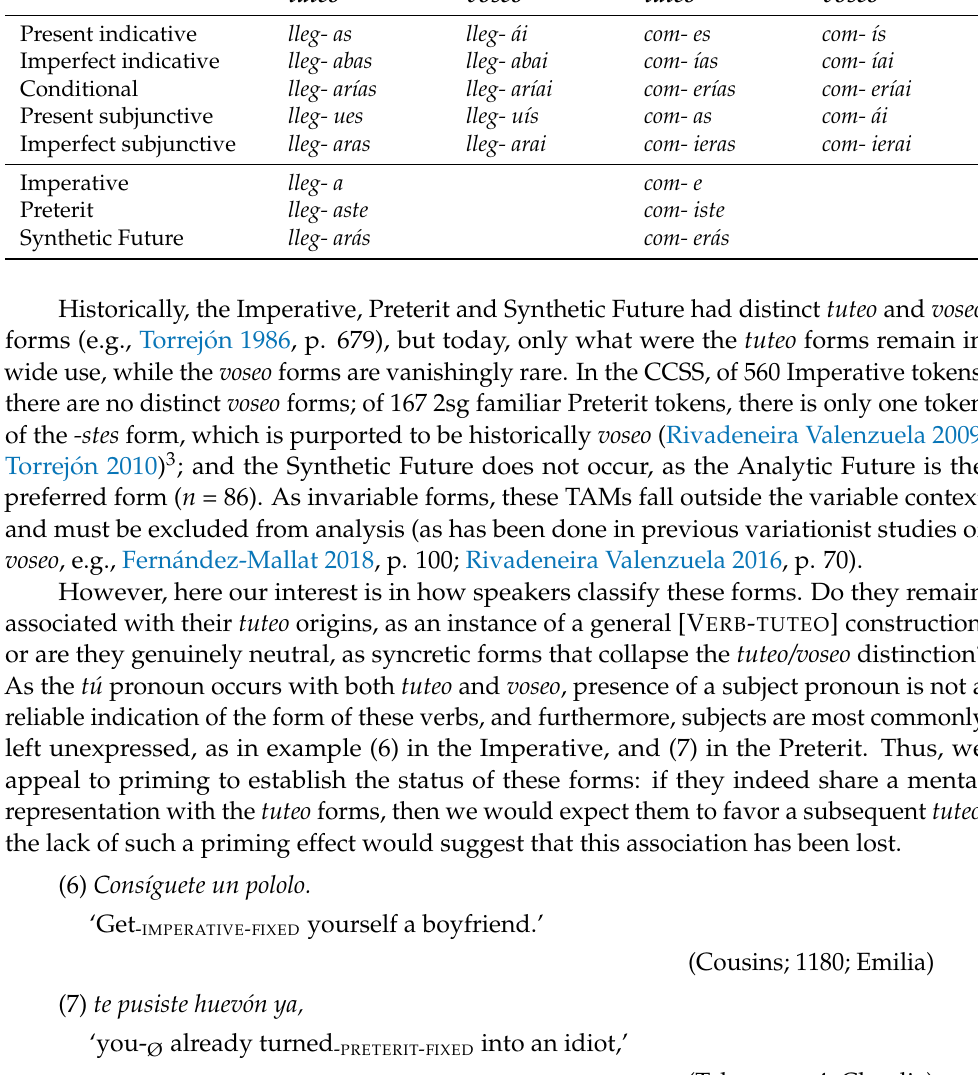
Table 2. Chilean 2sg verb morphology by tense-aspect-mood (Adapted from Torrej ó n 1986, p. 678). − AR Verbs − ER/ − IR Verbs tuteo voseo tuteo